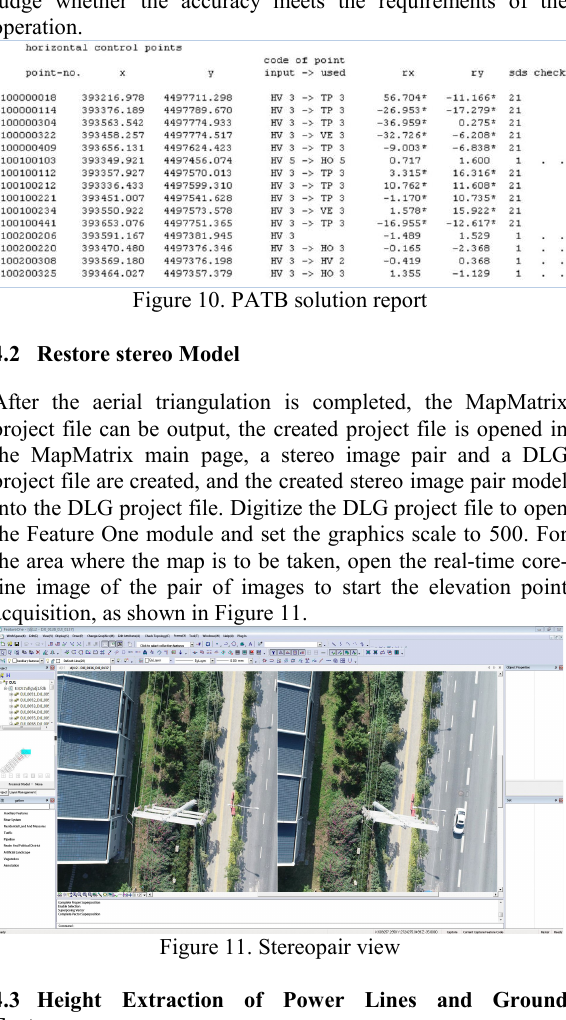
Table 2. Using the lidar point cloud data to verify the